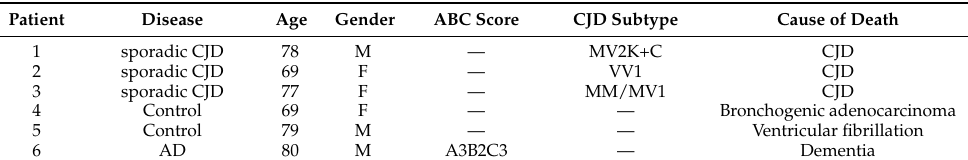
Table 1. Summary of clinical parameters of Creutzfeldt–Jakob disease patients, an Alzheimer’s disease (AD) patient, and age- and gender-matched human post-mortem control brain samples displayed in this review. All cases underwent standardized neuropathological assessment, including macroscopic and microscopic examination. sCJD and AD diagnoses were neuropathologically confirmed according to current criteria. Controls did not show any sign of neurologic or neurodegenerative diseases [73,97].